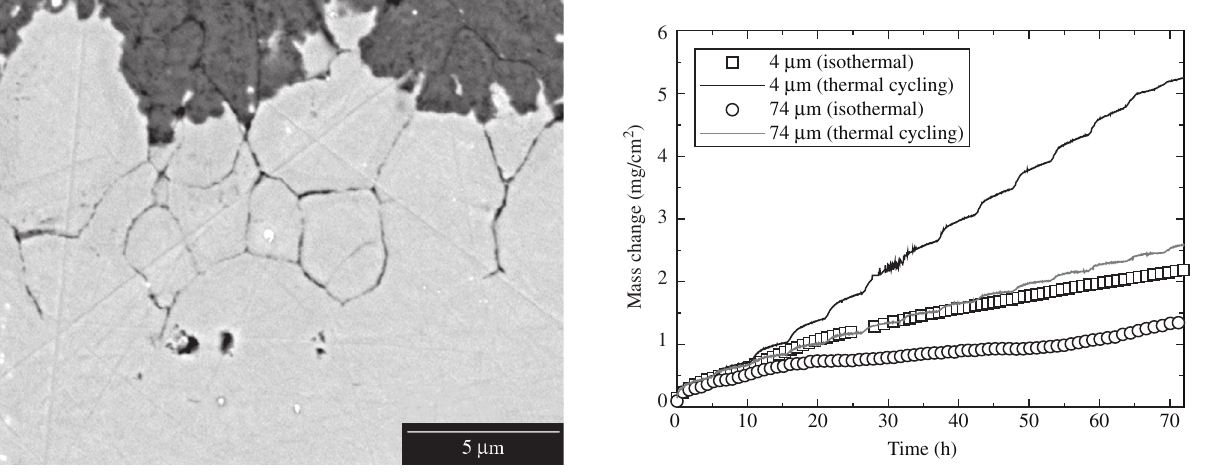
Figure 3. Intergranular oxidation in 2.25Cr1Mo steel with grain size of 4 µ m after exposure to laboratory air for 72 hours at 550 °C.